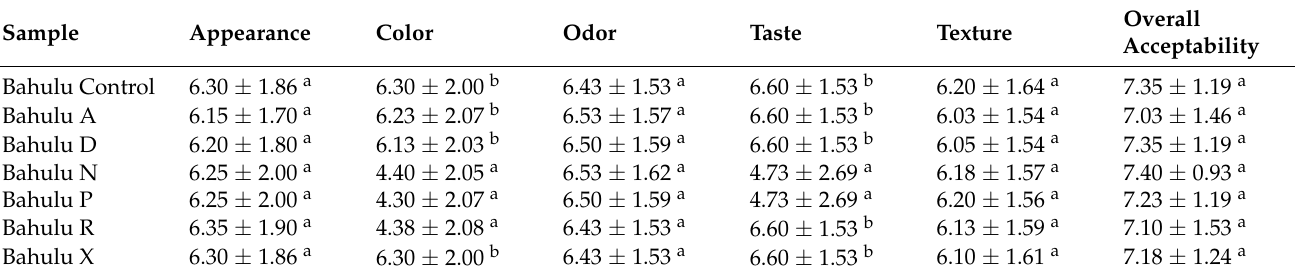
Table 7. Sensory properties of Bahulu